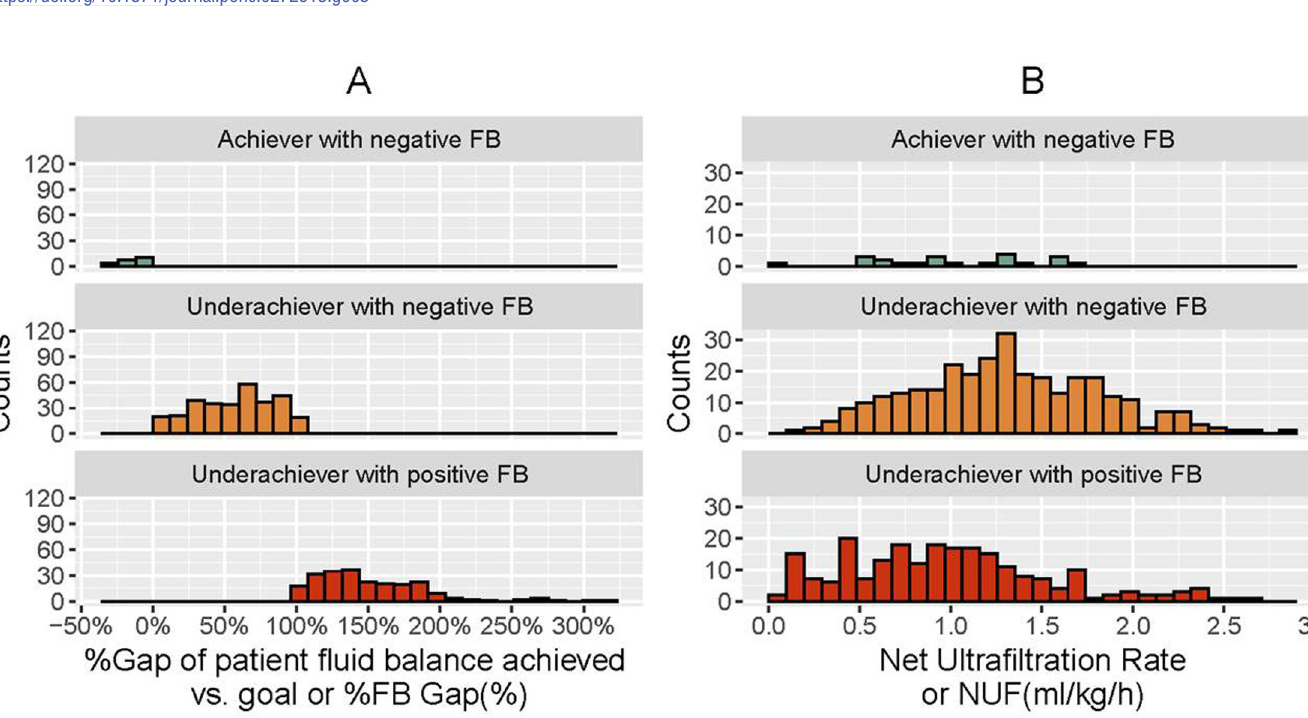
PLOS ONE | https://doi.org/10.1371/journal.pone.0272913 August 25,